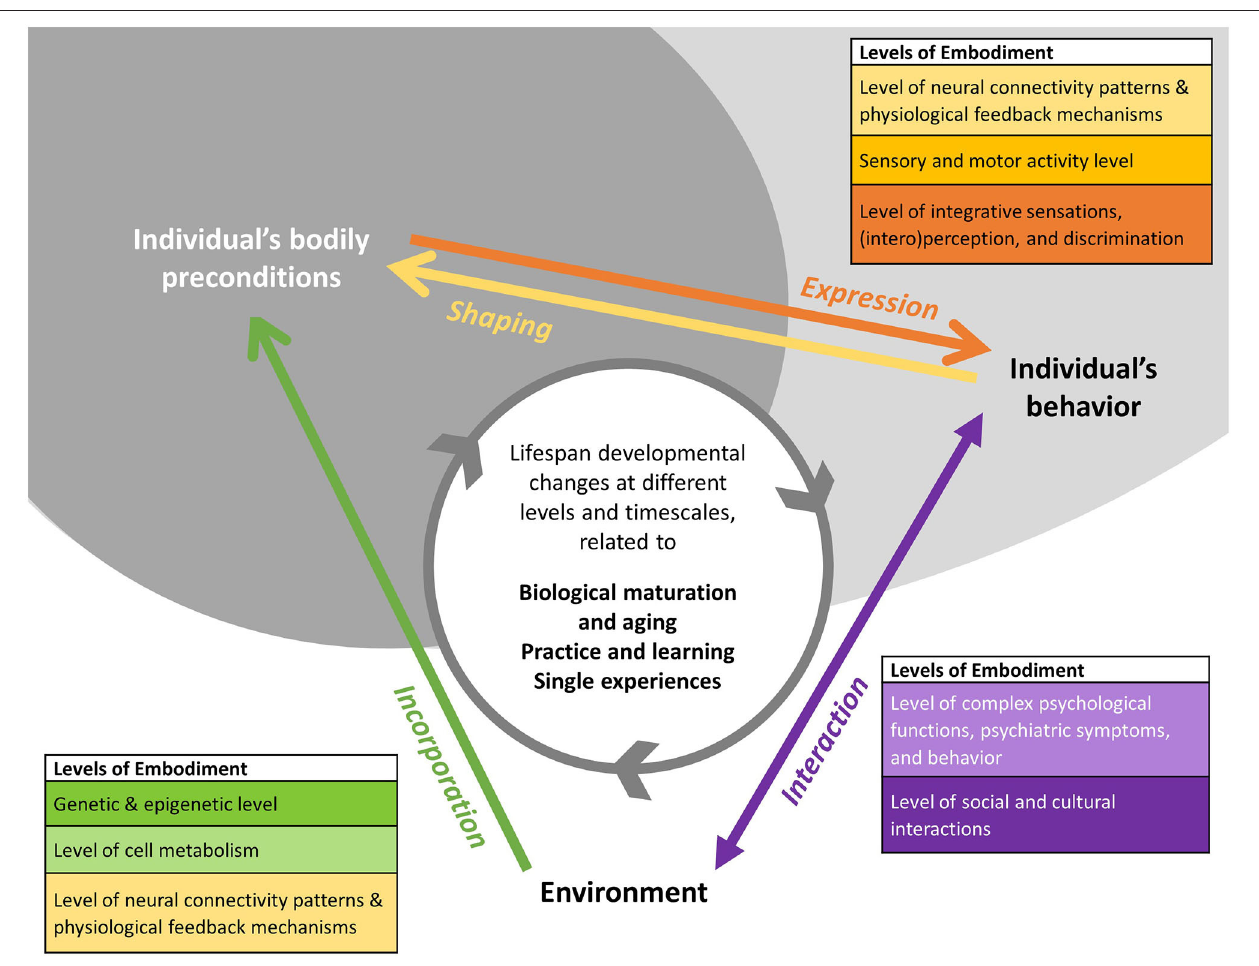
FIGURE 1 | Developmental perspective on embodiment. The figure illustrates how different conceptualizations of embodiment relate to each other from a developmental perspective. Arrows represent the different embodiment processes with the colors indicating the physiological and functional levels at which they are analyzed. The direction of the arrows indicates the perspective on the person-environment relationship. While environmental approaches focus on the process of incorporation of experiences over the lifespan (green arrow), agency approaches focus on the process of mobilization of embodied experiences and knowledge (purple arrow) within a specific behavior, emotional state or functional ability, simultaneously expressing and, through the action etc., shaping bodily preconditions (orange and yellow arrow). The developmental perspective emphasizes that both types of processes change the person-environment relationship. Lifespan changes of bodily preconditions, occurring at different timescales, result in lifespan developmental changes of embodiment phenomena and processes (gray colored circular